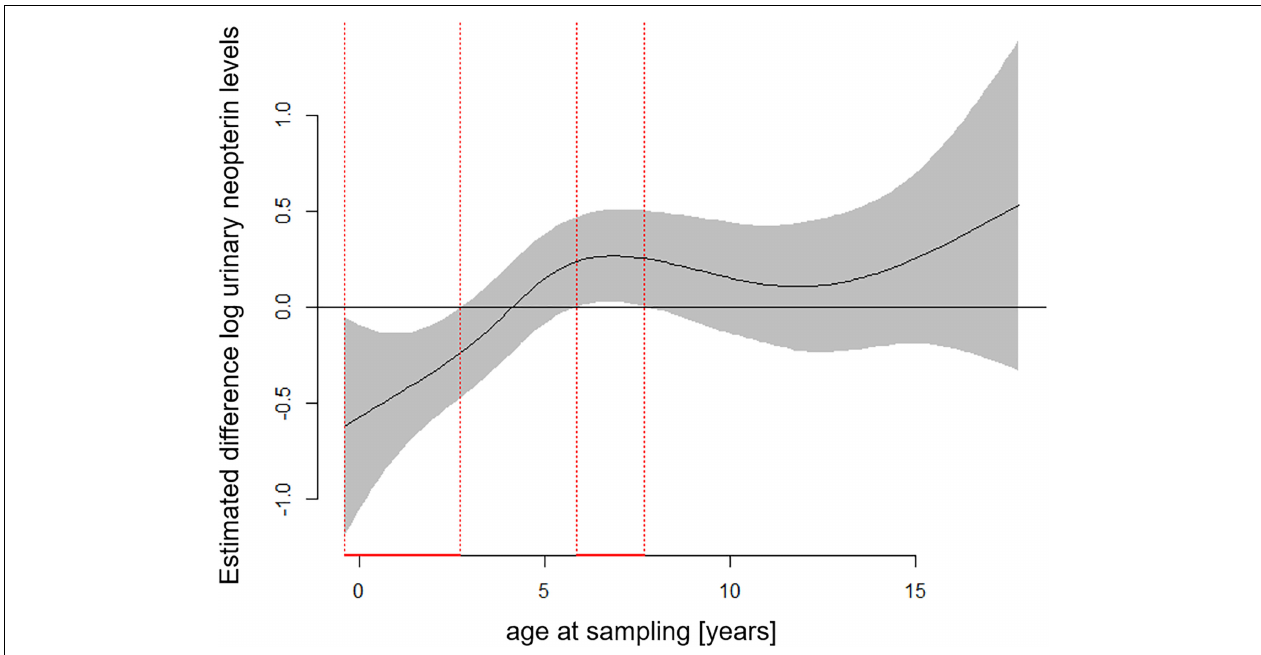
FIGURE 3 | Estimated differences in age-related urinary neopterin levels for male and female bonobos. Negative values represent higher neopterin levels in males and positive values represent higher neopterin levels in females. Age periods with significantly different neopterin levels between the sexes are indicated in red: Males have significantly higher neopterin levels between 0.4 and 2.7 years of age, while females have significantly higher levels between 5.9 and 7.7 years of age. Total N = 806 urine